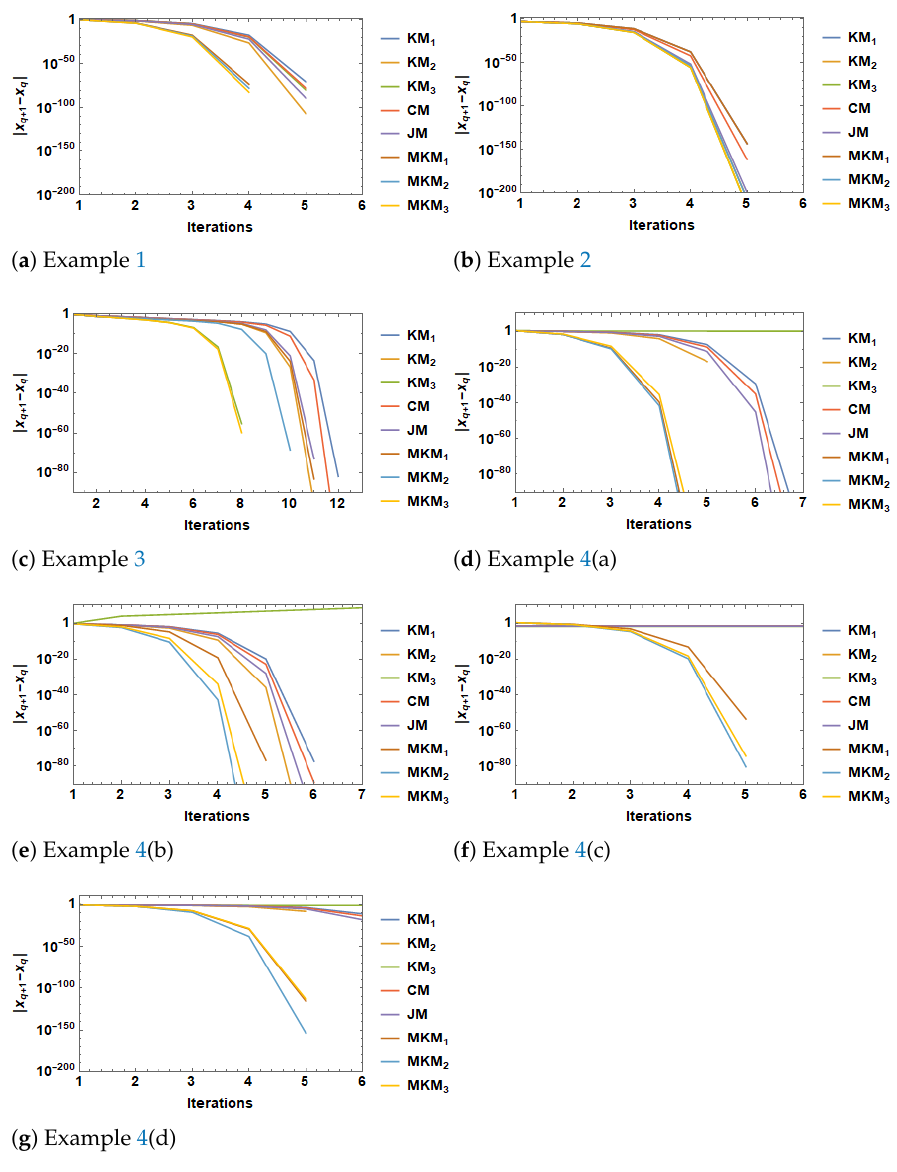
Figure 1. Graphical Error